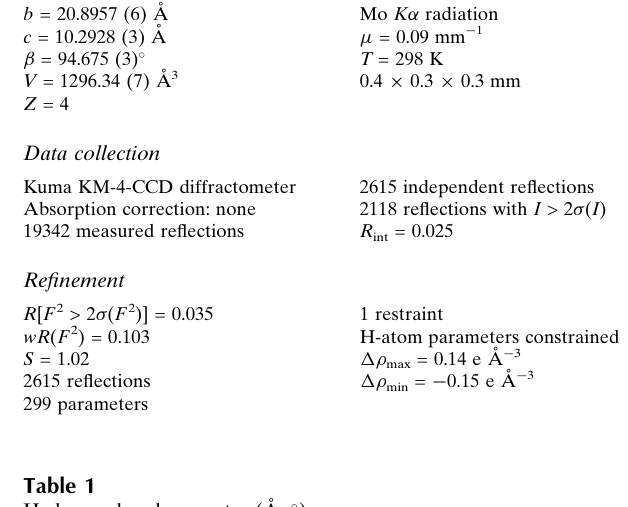
Hydrogen-bond geometry (A˚ , (cid:2)